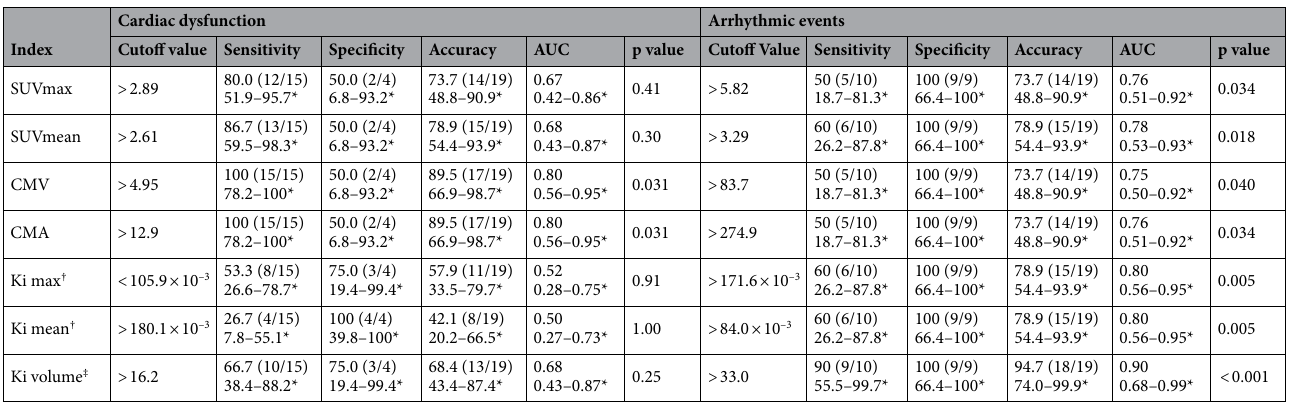
Table 3. Ability of SUV and Ki parameters to discriminate between the presence and absence of clinical events. CMV (cm3) cardiac metabolic volume, CMA cardiac metabolic activity, AUC area under the receiver operating characteristic curve. *95% confidence interval. † The unit of Ki max and Ki mean are ml/g/min. ‡ The unit of Ki volume was cm 3 .